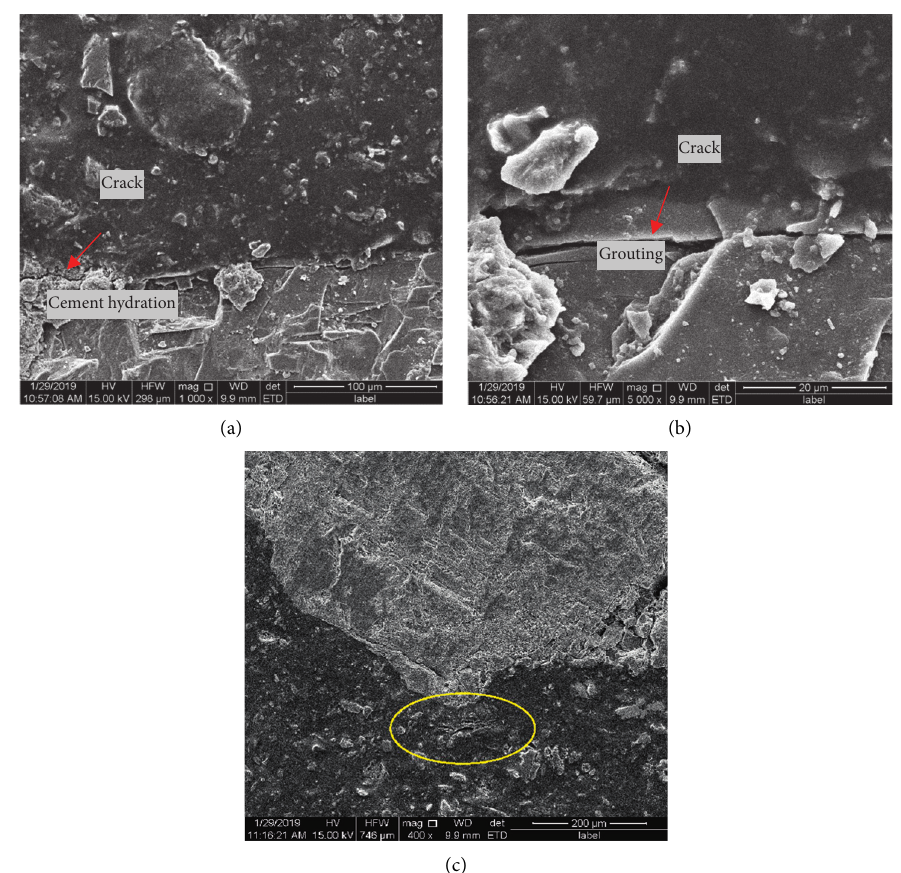
Figure 18: Morphology of SFP sample cured for 4 days. (a) Scale bar � 100 μ m. (b) Scale bar � 20 μ m. (c) Scale bar � 200 μ m.